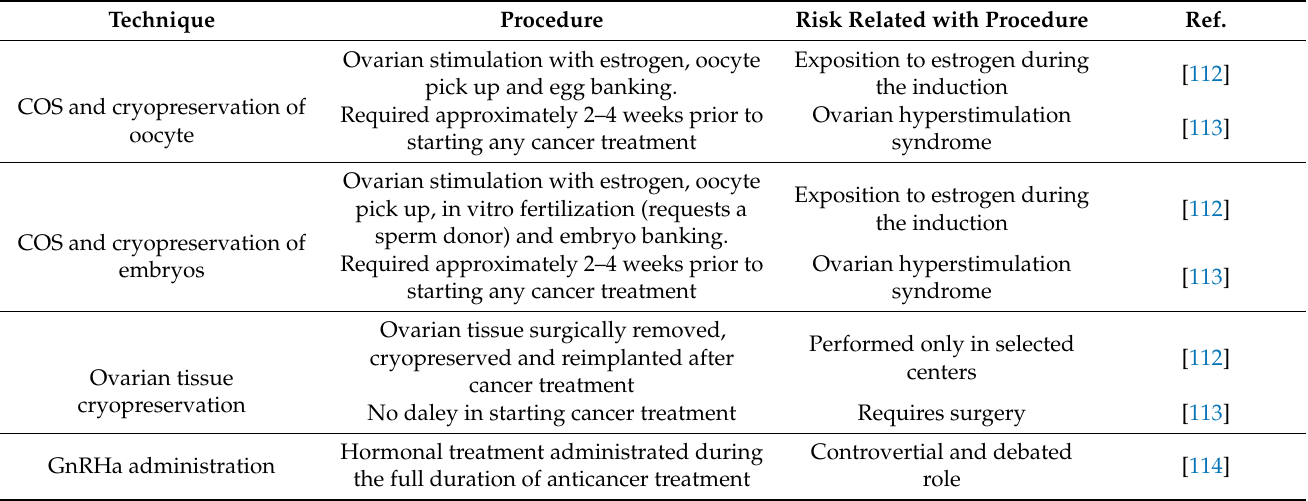
Table 2. Fertility preservation options for BC patients prior to and during anticancer